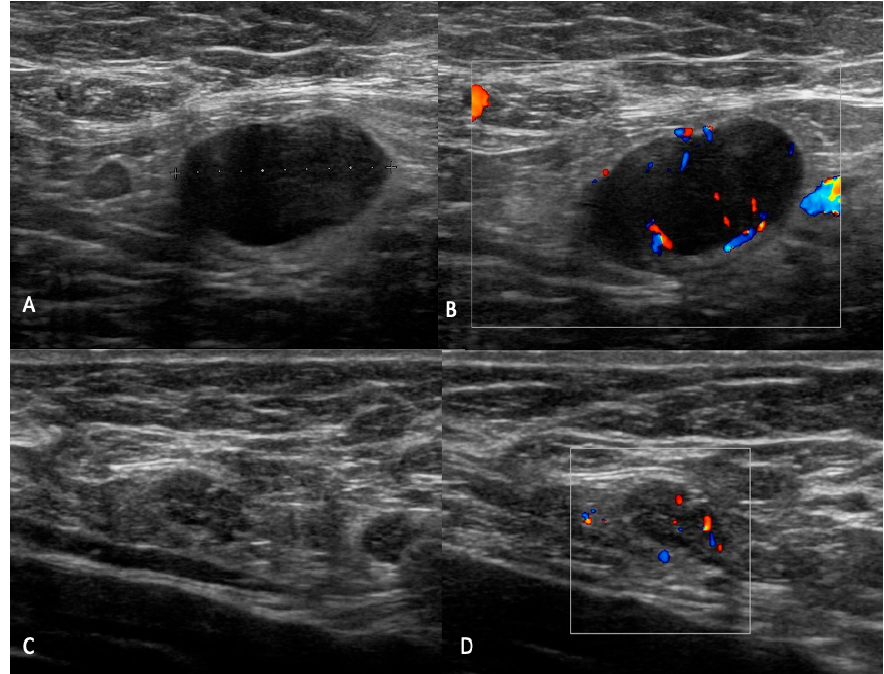
Figure 5. UN5: ( A ) B-mode sonogram image shows an enlarged hypoechoic lymph node with hilum absence. ( B , D ) Color flow images show aberrant vascular patterns with central and peripheral vascularization. ( C ) B-mode sonogram image shows a node with irregular margins, absence of fatty hilum and hyperechoic spots within.